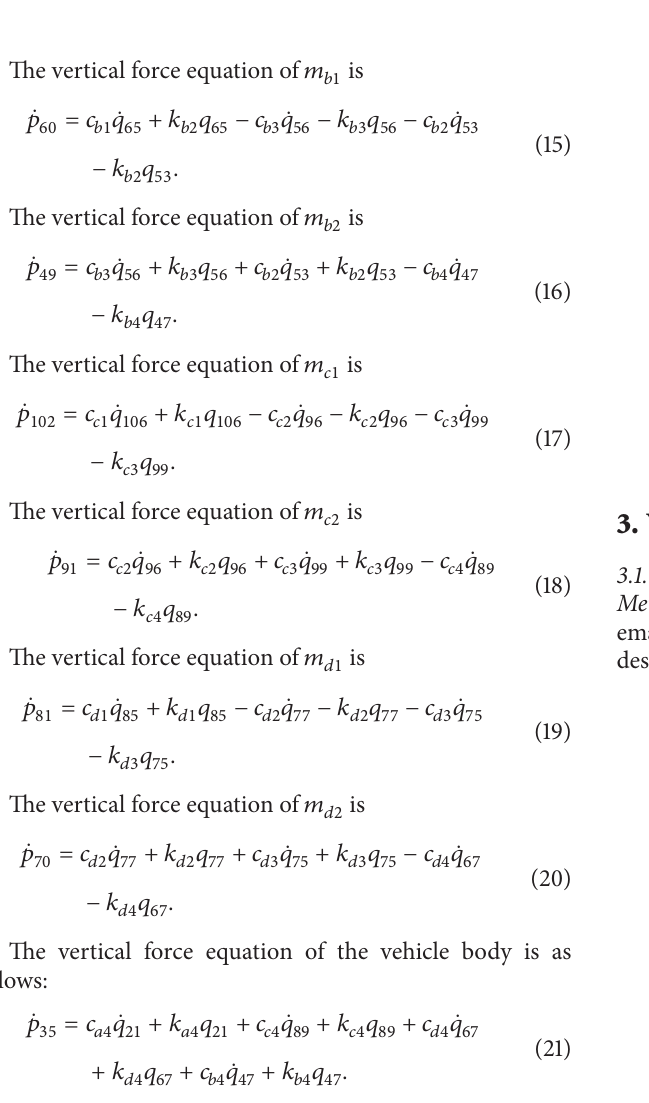
Figure 4: BG model of the vehicle body